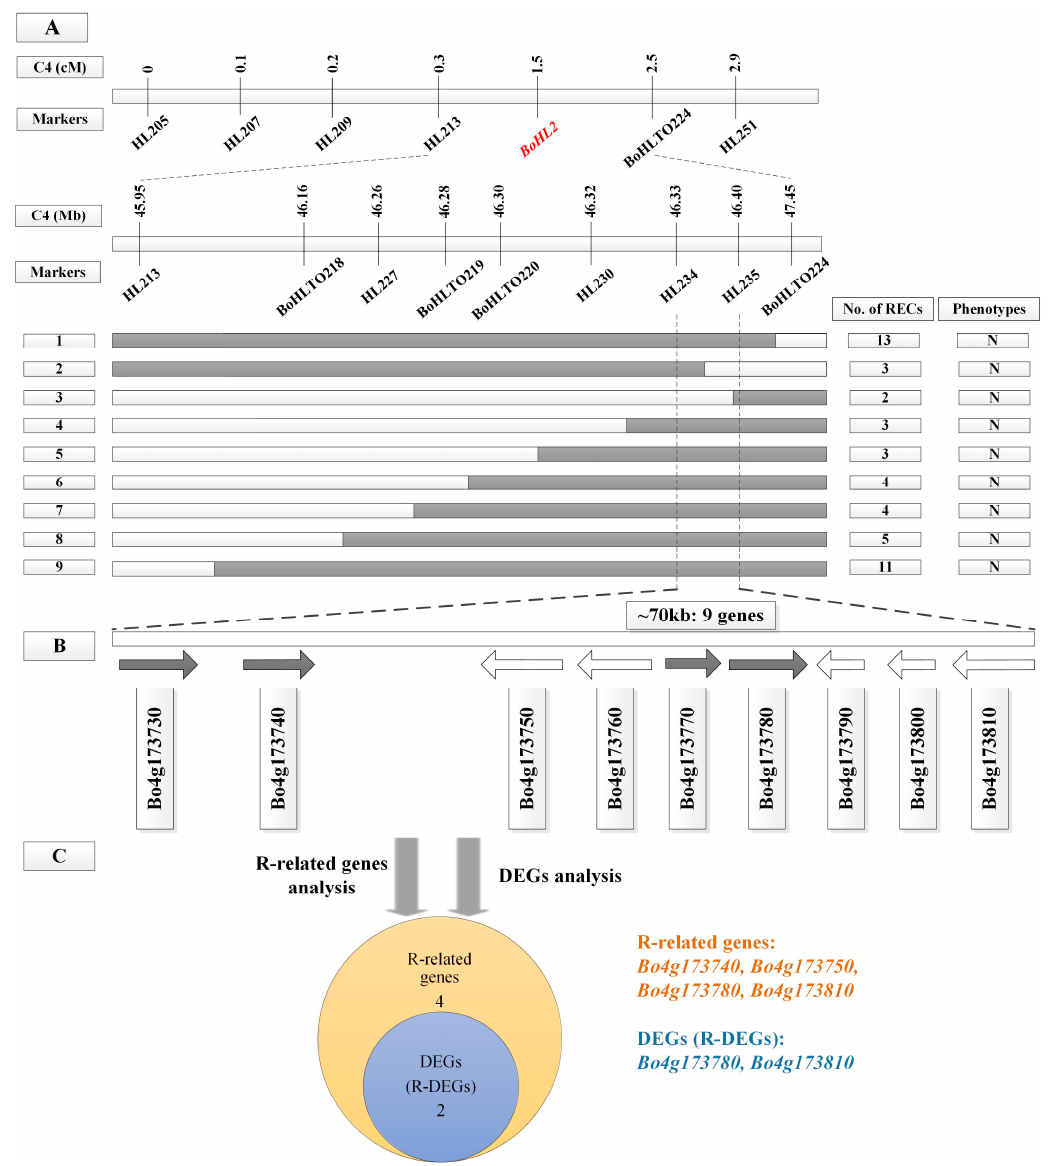
Figure 3. Fine mapping and analysis of BoHL2 . ( A ) A genetic map and corresponding physical map of BoHL2 . The BoHL2 gene was delimited to an interval between HL234 and HL235, with an estimated length of 70 kb. N: normal phenotype; ( B ) Nine genes were annotated in the ‘TO1000’ reference genome; ( C ) R-related gene analysis and DEG analysis for nine genes.